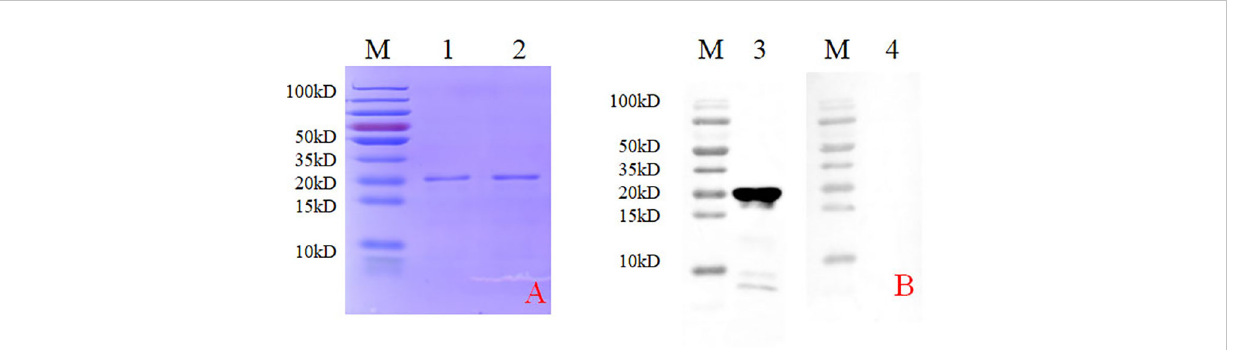
FIGURE 1 Identi fi cation of the recombinant N protein following bacterial expression and Ni-NTA af fi nity chromatography. (A) SDS-PAGE analysis. Lane M: protein marker; lanes 1 and 2: puri fi ed recombinant N protein samples. (B) Western blotting analysis using anti-His-tagged primary antibody. Lane 3, recombinant N protein; lane 4, negative control; SDS-PAGE, sodium dodecyl sulfate-polyacrylamide gel electrophoresis.